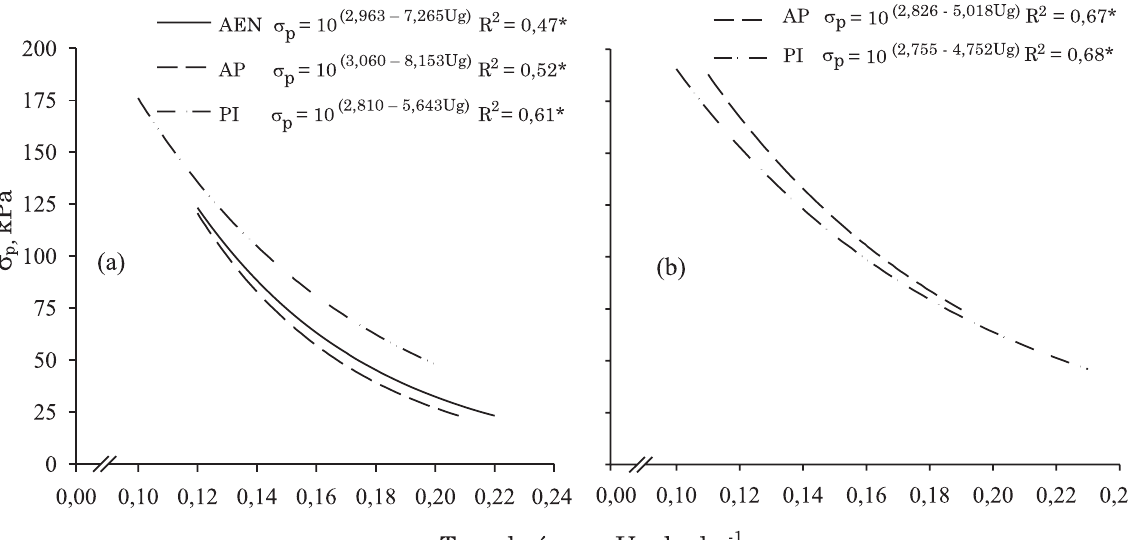
Figura 2. Modelos de capacidade de suporte de carga do solo de acordo com as coberturas de inverno, para as camadas de 0,03-0,06 m (a) e 0,12 a 0,15 m (b), nas áreas não trafegadas. AEN = aveia preta + ervilhaca (2002 a 2005) e nabo forrageiro (2006); AP = aveia preta; PI = pousio durante o inverno. * - Modelo estatisticamente significativo a 5